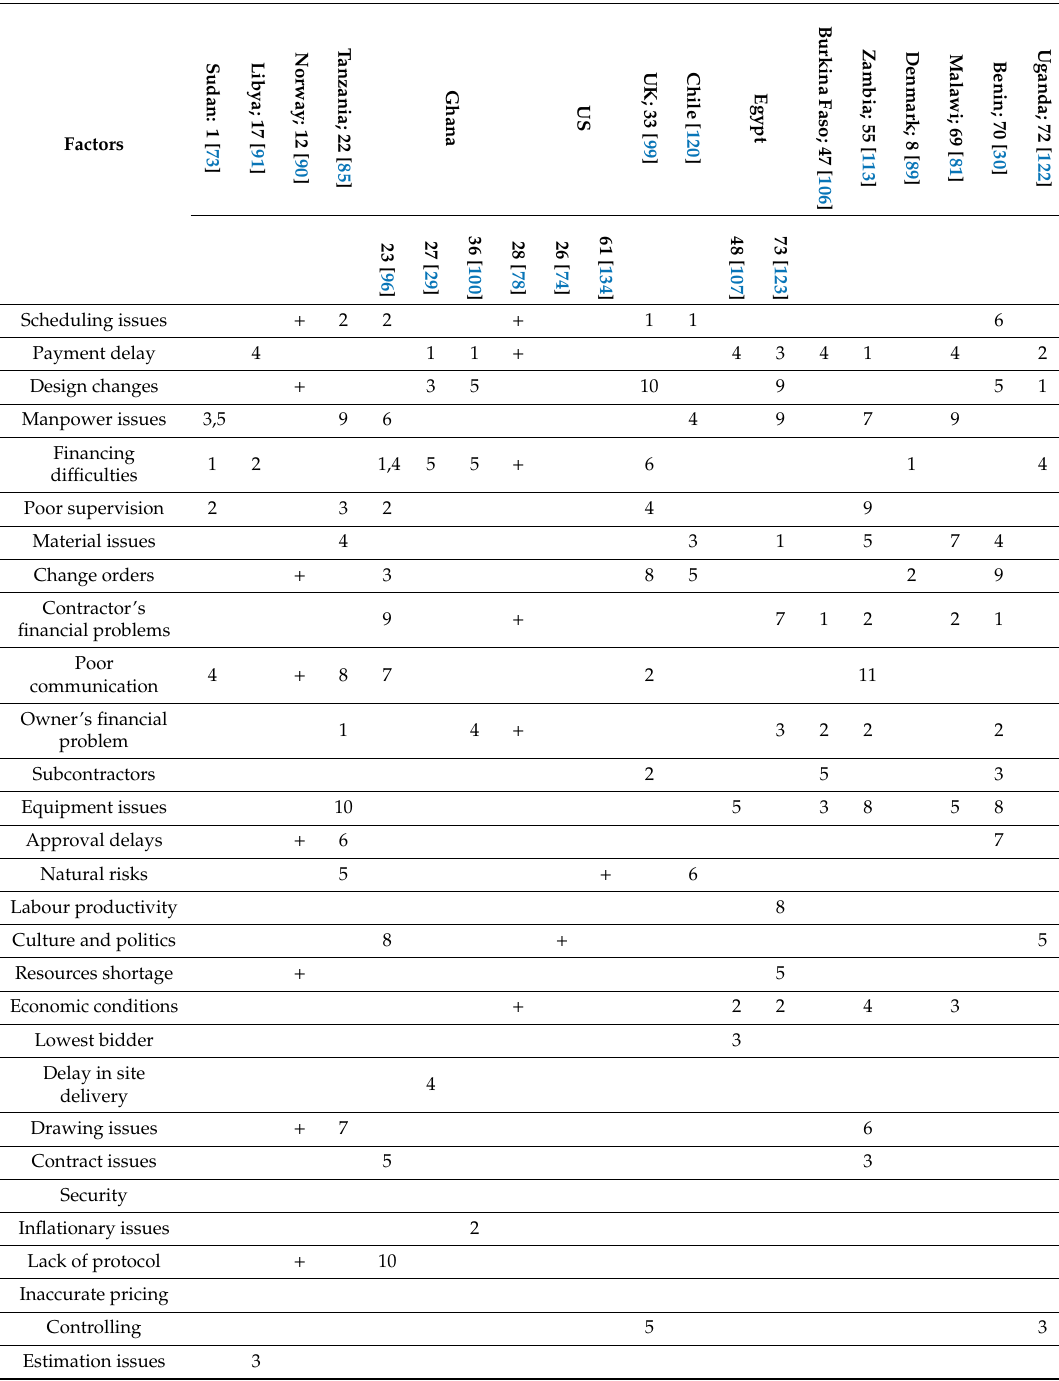
Table 8. Priority list of delay factors within DEC literature for African and other countries.